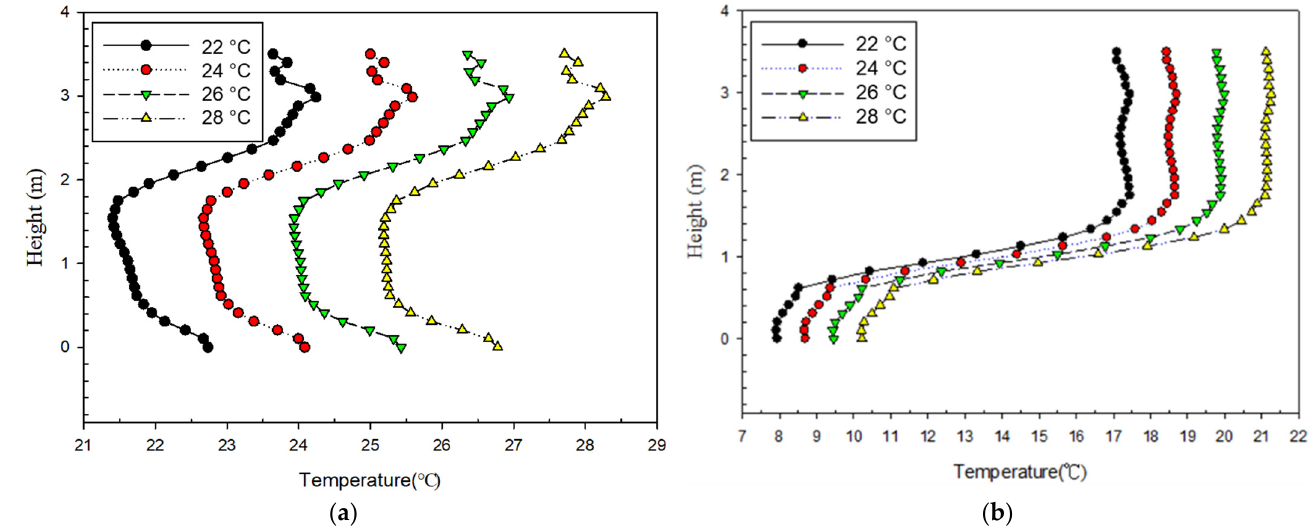
Figure 9. T emperature in different heights; ( a ) AC-1 near walkway; ( b ) AC-2 near CSS. Figure 9. Temperature in different heights; ( a ) AC-1 near walkway; ( b ) AC-2 near